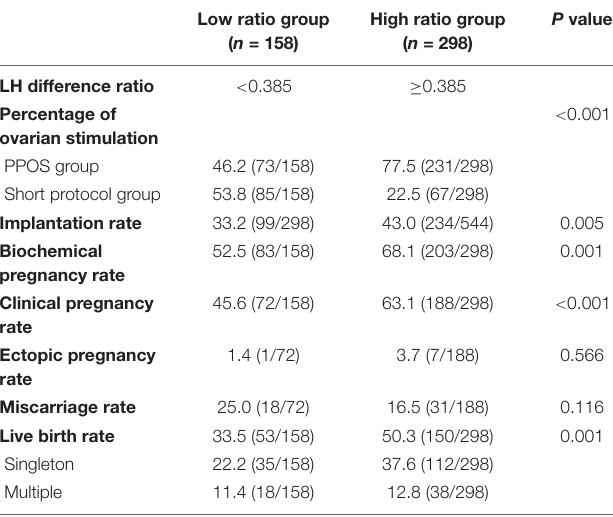
TABLE 3 | Comparison of clinical outcomes in patients with PCOS stratified according to the LH difference